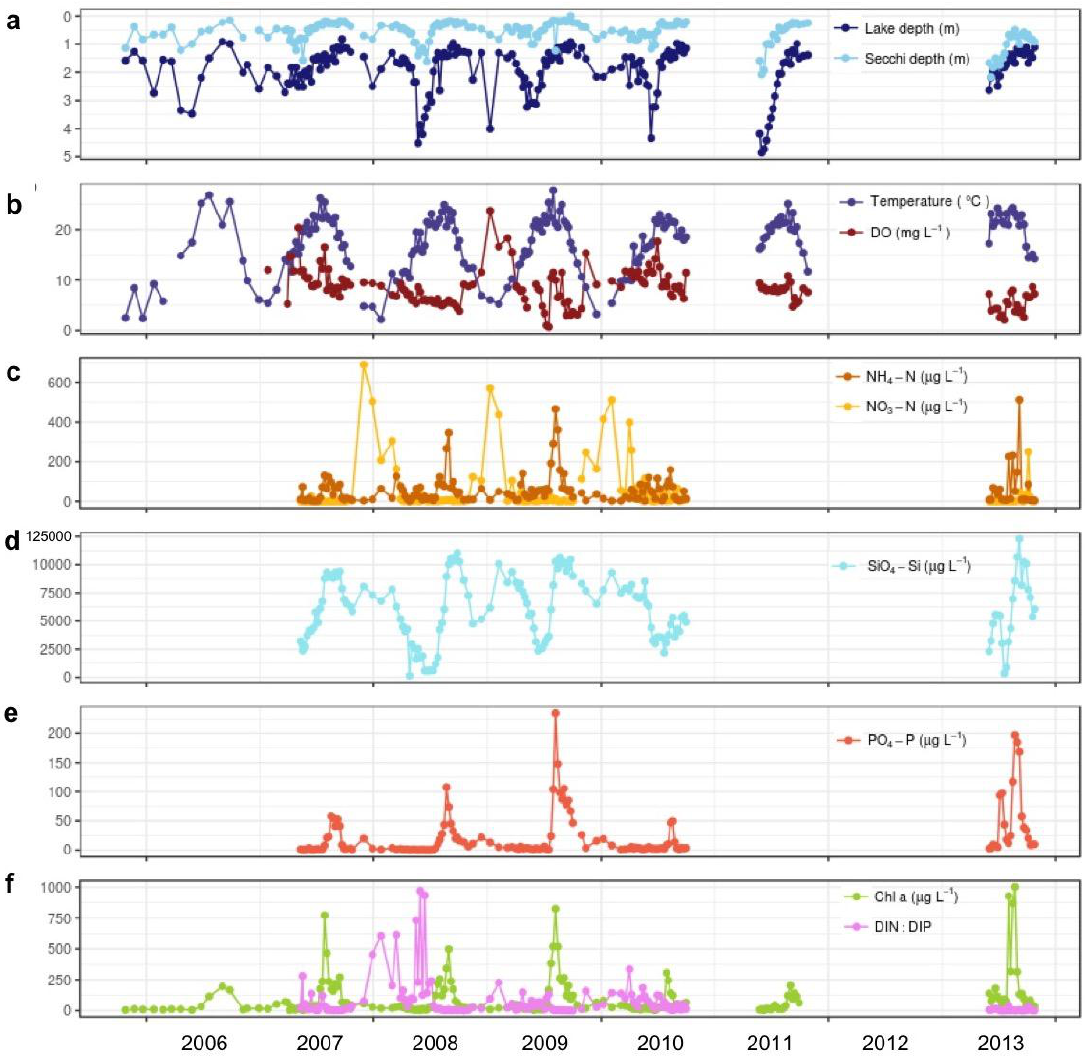
Figure 3. Water quality measurements in Vancouver Lake from October 2005 to October 2013. ( a ) water depth and Secchi depth; ( b ) temperature and dissolved oxygen (DO) concentrations; ( c ) NH 4 -N and NO 3 -N concentrations; ( d ) SiO 4 -Si concentrations; ( e ) PO 4 -P concentrations; ( f ) chlorophyll a concentrations and DIN:DIP. Data from [49,62] and G. Rollwagen-Bollens et al. (unpublished).